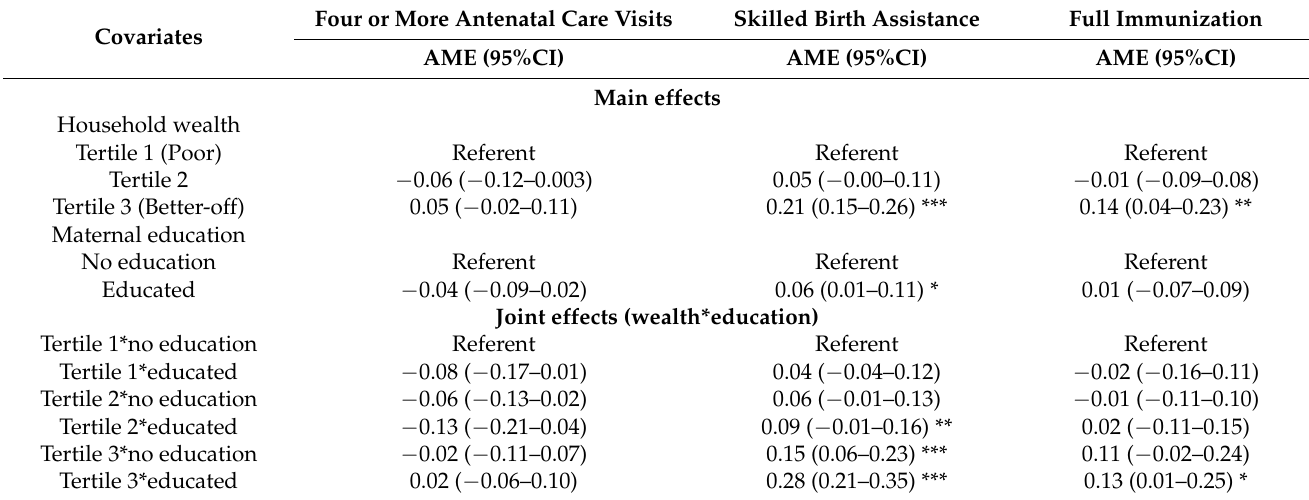
Table 3. Probability of utilization of four or more antenatal care visits, skilled attendance at delivery, and full immunization of children aged 12–23 months by household wealth, maternal education, and their interaction. Average marginal effect estimates (main effects and interactions) based on multivariable logistic regression.